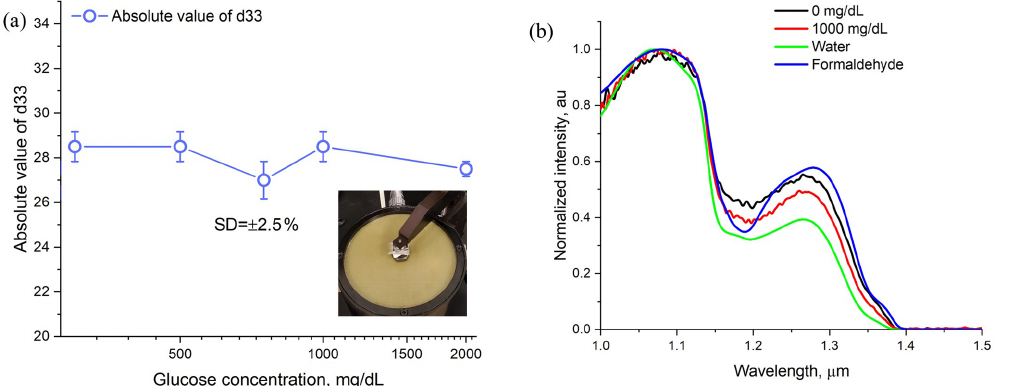
Figure 3. (a) Value of d33 of different phantom samples with varying glucose concentration, inset: sample was placed on top of the d33 meter, (b) FTIR characterization of the samples with all the constituents of 0 and 100mgdL − 1 of aqueous glucose solution, water, and